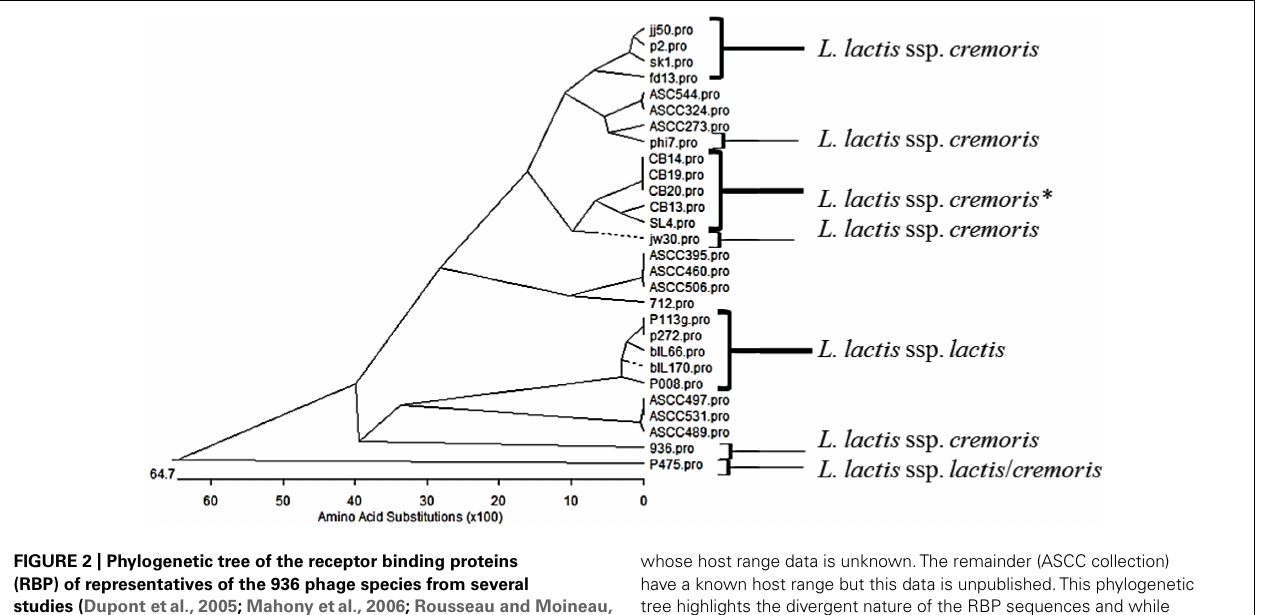
FIGURE 2 | Phylogenetic tree of the receptor binding proteins (RBP) of representatives of the 936 phage species from several studies (Dupont etal., 2005; Mahony etal., 2006; Rousseau and Moineau, 2009a; Castro-Nallar etal., 2012). Phages that have been demonstrated to infect specifically L. lactis ssp. cremoris or ssp. lactis , are highlighted and P475 which infects both subspecies is also highlighted. *Indicates phages that have been propagated on a L. lactis ssp. cremoris strain but